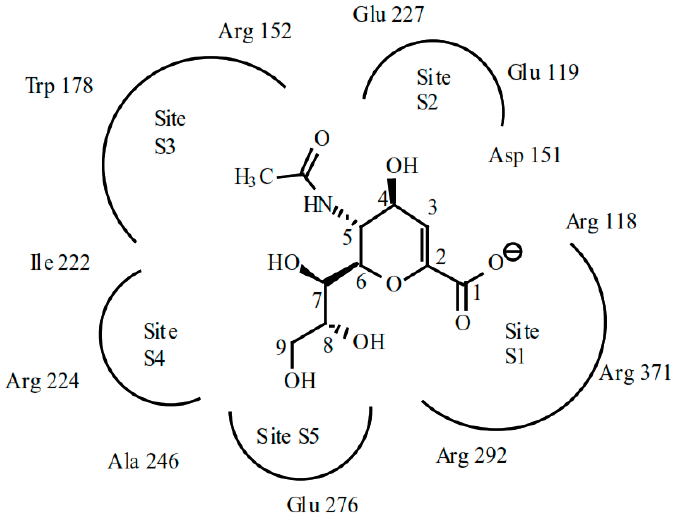
Figure 7. Diagram of NA active site with dehydrodeoxy- N -acetylneuraminic acid (DANA) inhibitor showing the five inhibitor binding sub-sites and nearby critical residues [188].